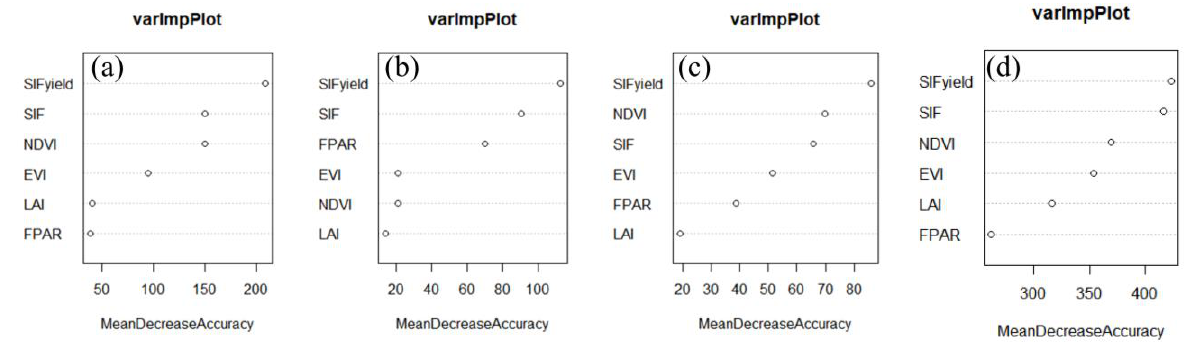
Figure 9. Variable importance (x axis value) of remote sensing variables for explaining the perfor- mances of each variable in detecting drought event. ( a ) Yunnan province; ( b ) Fujian province; ( c ) Shaanxi province; and ( d ) Heilongjiang province.